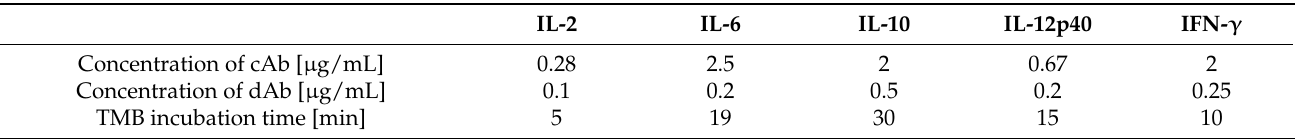
Table 2. Working concentrations of capture antibody (cAb) and detection antibody (dAb) and incubation time for TMB